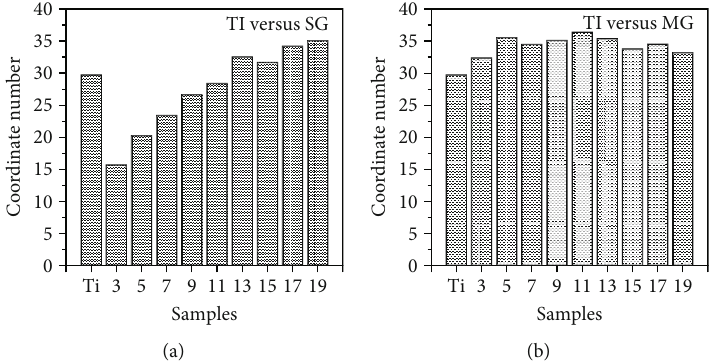
Figure 7: Coordinate numbers of the simulation realizations: (a) single-grid scheme; (b) multiple-grid